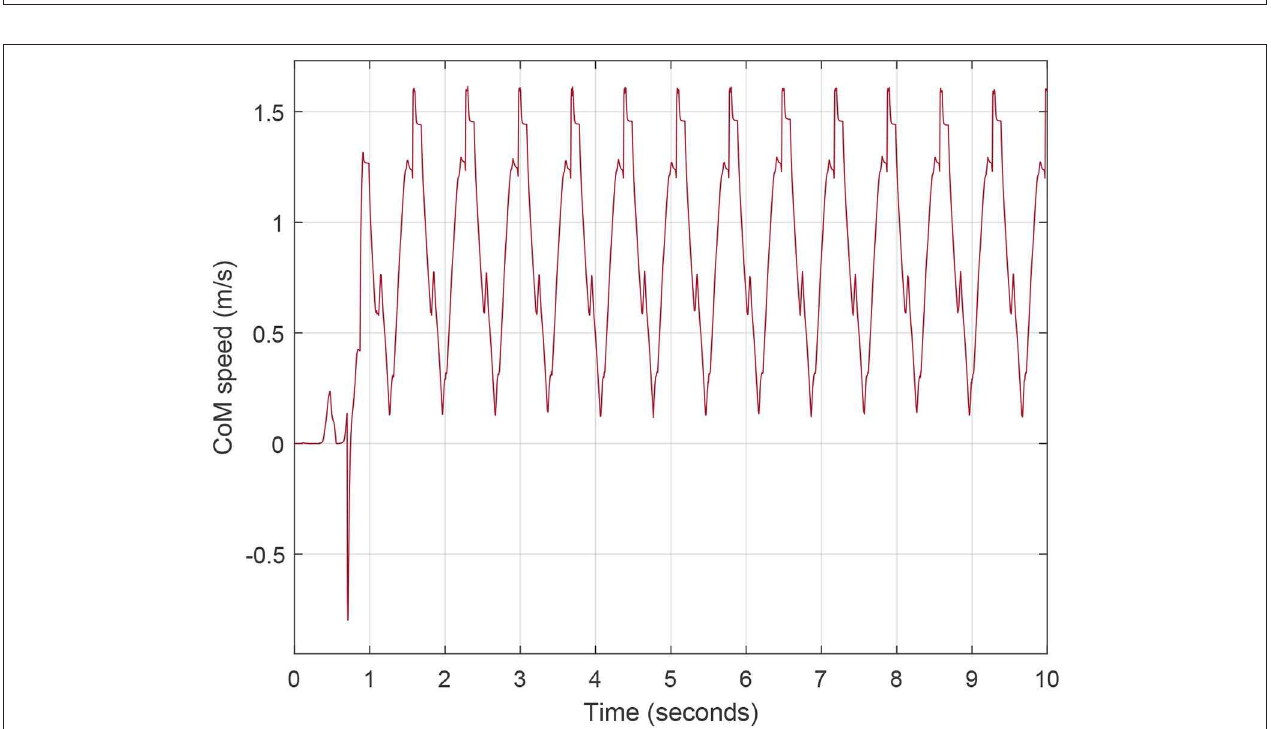
FIGURE 7 | Speed of the Center of Mass (CoM) of the Robot model I walking gait with infinite stiffness